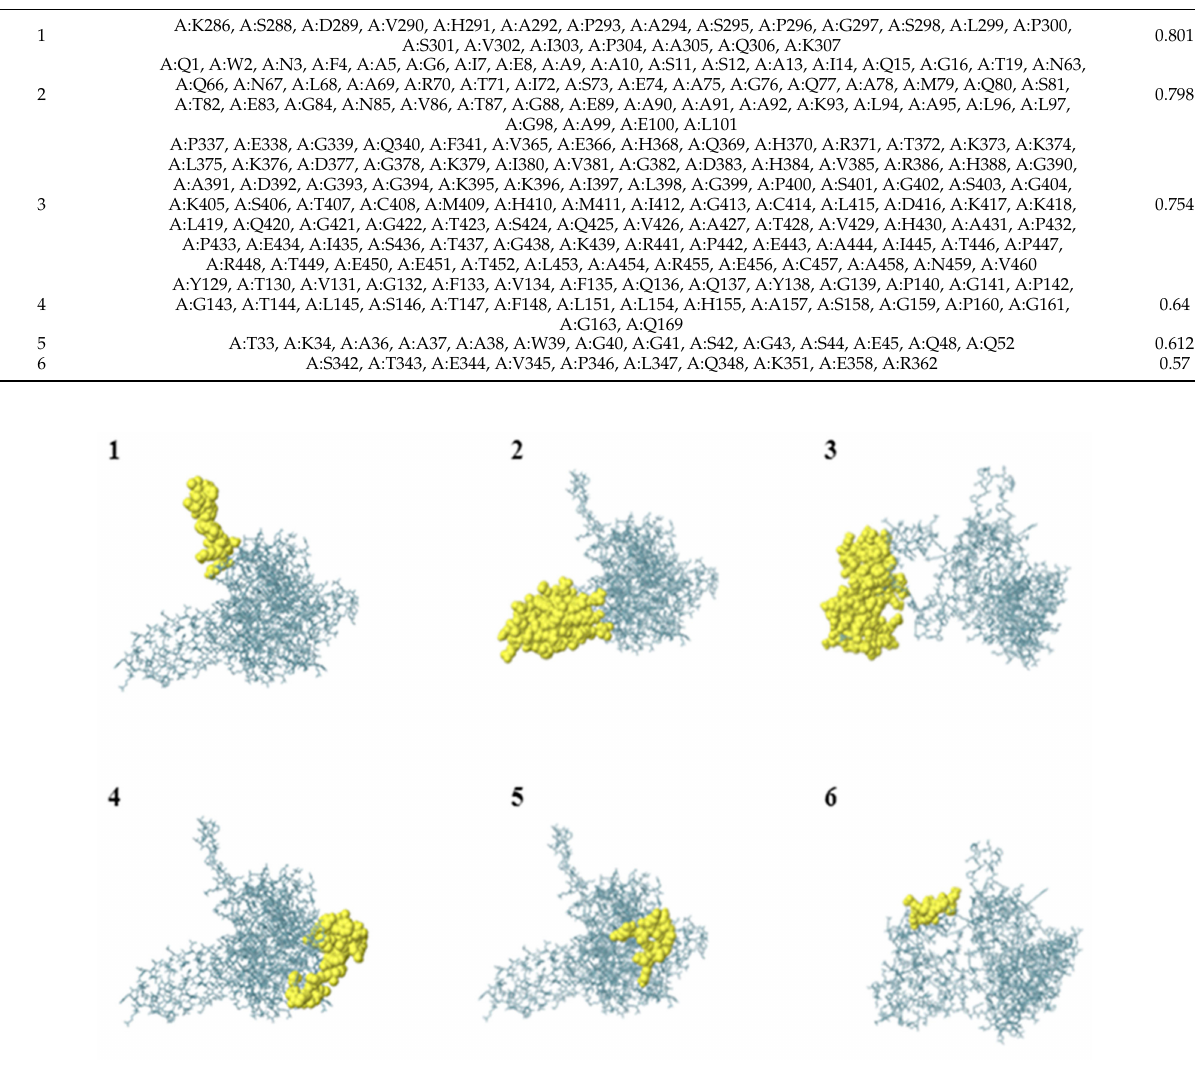
Figure 14. ElliPro predicted discontinuous B-cell epitopes. ( 1 – 6 ): 3D visualization of conformational or discontinuous epitopes of T. pallidum most antigenic protein. Yellow surfaces indicate epitopes, whereas grey sticks represent most of the